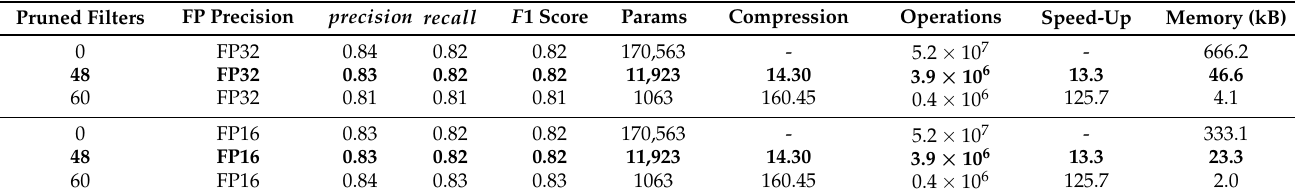
Figure 11. Model performance and network complexity for different number of filters. Table 2. A comparison of the performance, memory usage and computation complexity for pruned and original networks for FP16 and